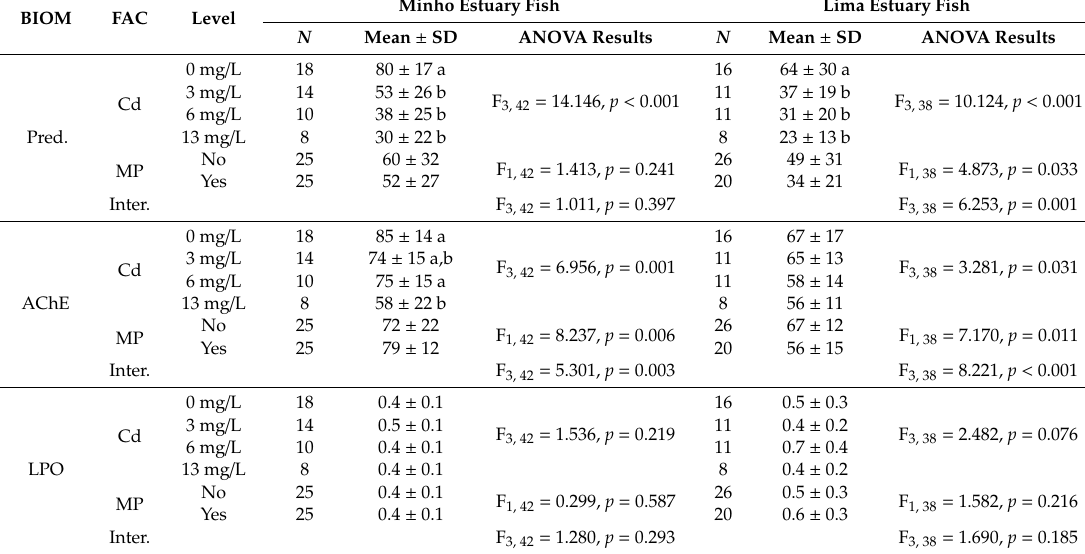
Table 2. Results of two-way ANOVA with interaction (fixed factors: cadmium concentration and microplastics presence) carried out with Pomatoschistus microps juveniles from the estuaries of Minho and Lima rivers. BIOM—Biomarker. FAC—Factor. Pred.—predatory performance. AChE—Acetylcholinesterase activity (nmol / min / mg protein). GST—Glutathione S